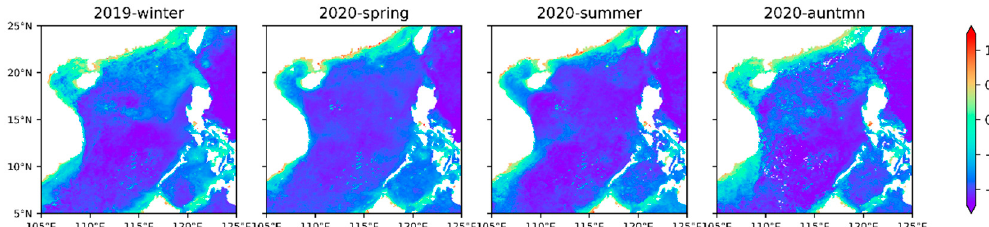
Figure 7. Seasonal average abundance distribution of Chl a in the SCS.